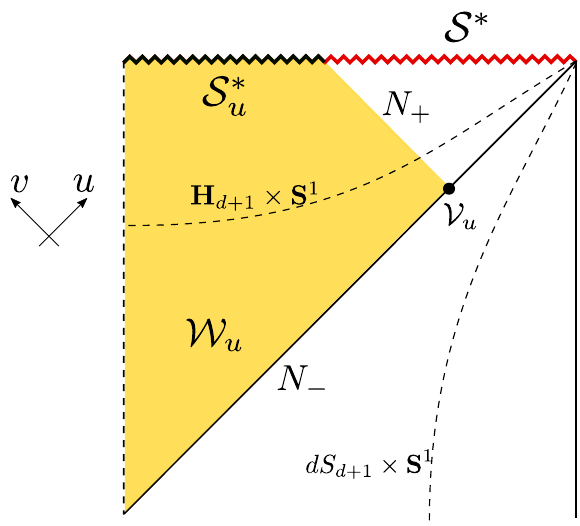
Figure 2 . The causal structure of the topological crunch singularity and its associated WdW